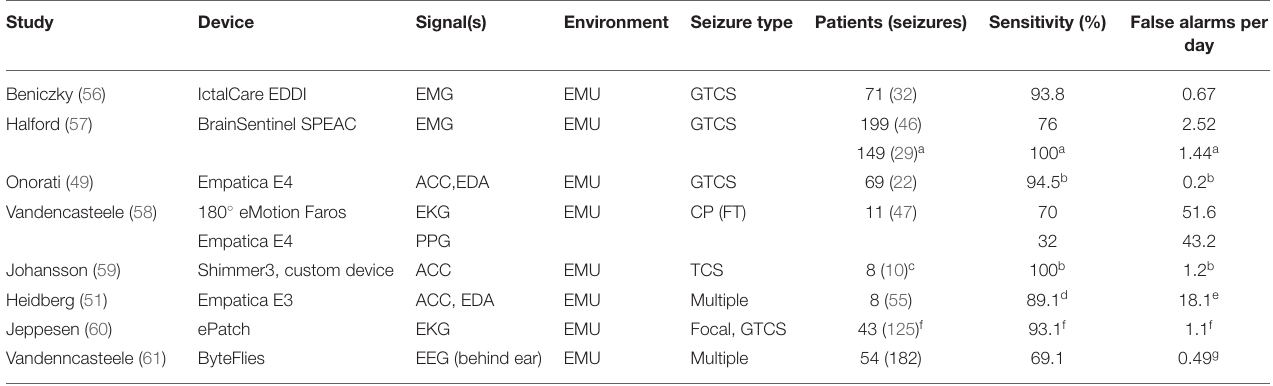
TABLE 1 | Sensitivity and false alarm rates for detection of seizures with wearable biosensors.